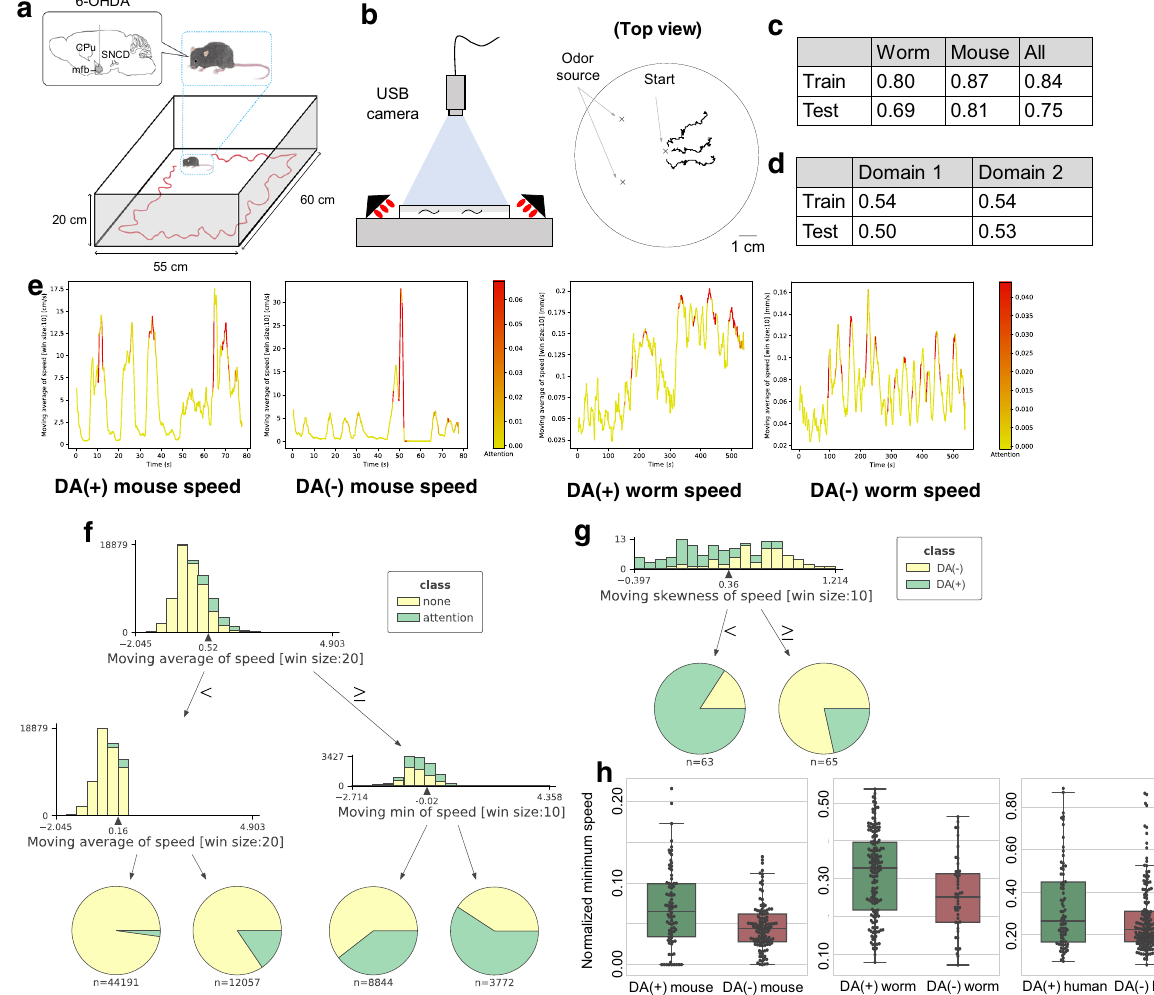
Fig. 2 Analysis of DA( + )/DA( − ) mice and worms (DA: dopamine). a A Parkinson ’ s disease (PD) mouse walks in the experimental setup, where dopaminergic neurons in the substantia nigra pars compacta were unilaterally lesioned with 6-hydroxydopamine. b The experimental setup (left) for monitoring the worm ’ s trajectory (right). c Classi fi cation accuracies of our network for DA( + )/DA( − ) classes. d Classi fi cation accuracies of our network for the 1st and 2nd domain estimates, where the random guess ratio is 0.5 (1/2); see Supplementary Information for the detailed results of the domain estimates. e Example time-series of speed of DA( + )/DA( − ) mice and worms highlighted by our network. f A decision tree for explaining the meaning of attention by the neural network, i.e., classifying attended (`attention') and non-attended (`none') segments, where features were normalized for each trajectory (min – max normalization); we show only the 1st and 2nd layers and each histogram shows a tree node of the tree, and a feature used in the node is indicated at the bottom of the histogram; a histogram of each node is constructed from training instances' values of a feature used in the node, instances having feature values smaller than a threshold go to the left child, the threshold value is shown at the bottom of each histogram associated with a black arrow and pie charts at the bottom of the tree (leaf nodes) show distributions of training instances classi fi ed by the tree. g A decision tree for explaining classi fi cation, where we show only the 1st layer. h Distributions of averaged minimum speed within a time window when the speed is high for mice/worms; to compute the averaged minimum speed, we compute the rolling minimum of the normalized speed within segments with high speed (top 20% average speed) for each trajectory (see Supplementary Information for details) and the box plot shows the 25 – 75% quartile, with embedded bar representing the median and the lower/upper whiskers show Q1-1.5*IQR and Q3 + 1.5*IQR, respectively, where IQR is the interquartile range, Q1 is 25% quartile, and Q3 is 75% quartile; signi fi cant differences between DA( + ) and DA( − ) for both the mice and worms are observed (worm by the Brunner – Munzel test: p = 7.61 × 10 − 4 : w = 3.48; df = 90.41; effectsize = 0.65; n = 162 from DA( + ) worms; n = 47 from DA( − ) worms; mouse by the Welch ’ s t -test: p = 2.53 × 10 − 3 ; t = 3.07; df = 131.45; effectsize(r) = 0.45; n = 88 10 min trajectories from DA( + ) mice; n = 113 10 min trajectories from DA( − ) mice); a signi fi cant difference between DA( + ) and DA( − ) for the humans is also observed by the Welch ’ s t -test ( p = 0.03; t = 2.25; df = 123.83; effectsize(r) = − 0.32; n = 78 from DA( + ) humans; n = 163 from DA( − ) humans); the p value is two sided; see Supplementary Information for the normality tests of the distributions, which were used to select methods of statistical test for comparing two